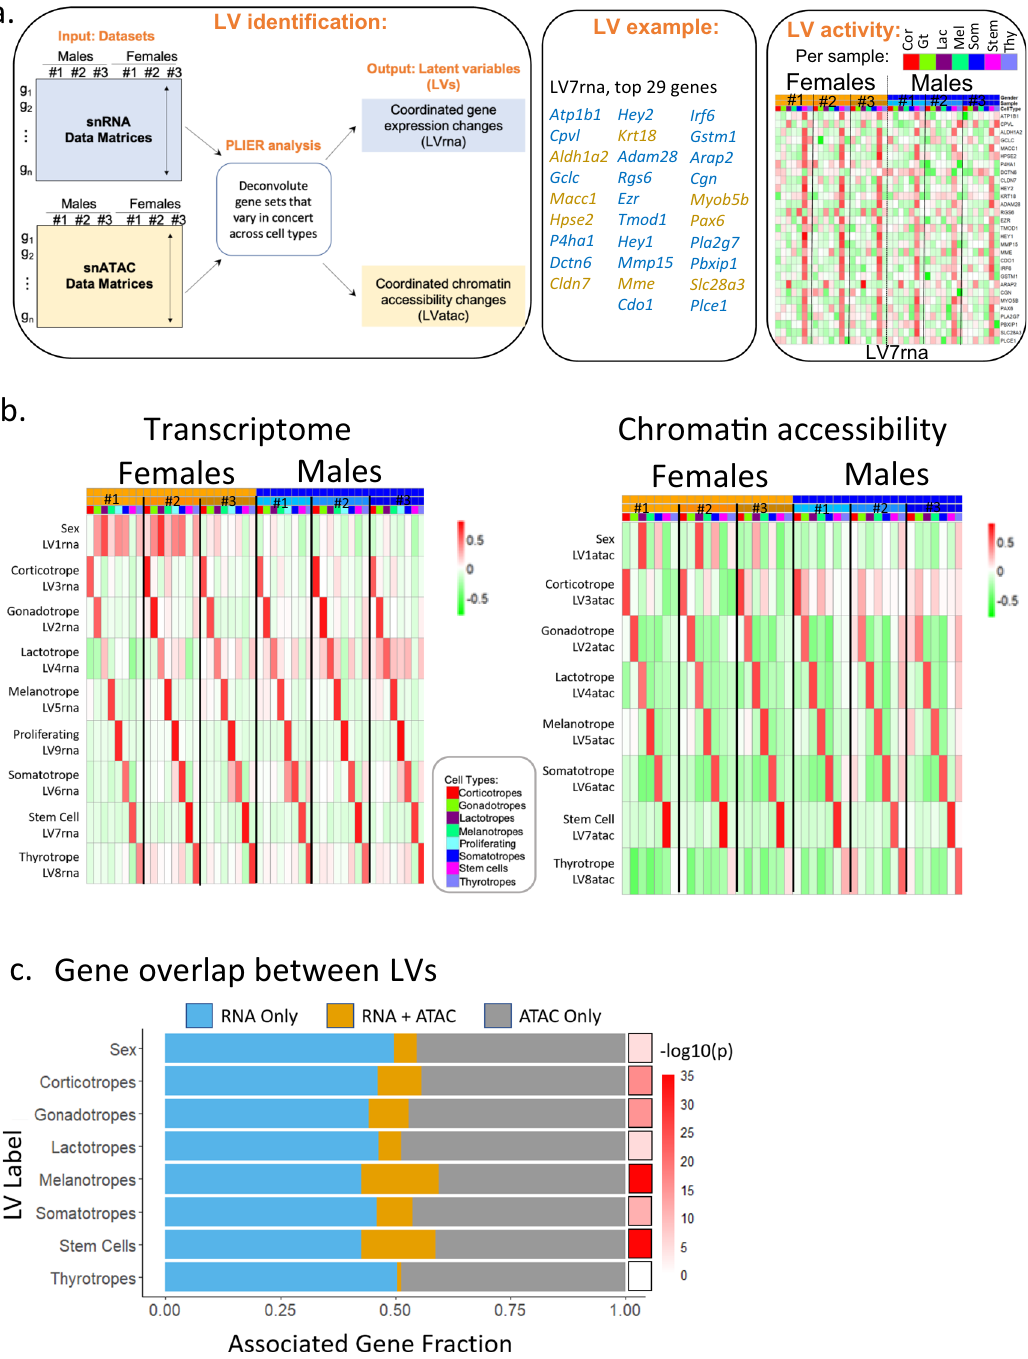
Fig. 7 Cell type characterization based on speci fi c coordinated gene expression and chromatin accessibility programs. a Left panel, Schematic of PLIER functionality. SnRNAseq and snATACseq data matrices are generated for all six individual animals. In these data matrices, PLIER identi fi es sets of genes (latent variables, LVs) that show coordinated gene changes across different cell types or samples. These LVs are matched with publicly available information such as gene pathway sets. Middle panel, Example of the top 29 genes in LV7rna. Genes speci fi c to LV7rna are in blue, while genes that are common between LV7rna and LV7atac are in gold. Right panel, Example of LV activity shows the expression levels of the top 29 genes in LV7rna for each pituitary cell type and individual animal. b Heatmaps of the levels of expression (Left) and chromatin accessibility (Right) of each LV for a speci fi c animal/ cell type, including LV7rna and LV7atac that are exempli fi ed above. Each of the six individual samples is indicated. In the scale bar, red represents the highest level of gene expression or chromatin accessibility. c Graph showing the gene overlap (gold) between the RNAseq (blue) and ATACseq (grey) LVs for each cell type. The scale bar indicates the p